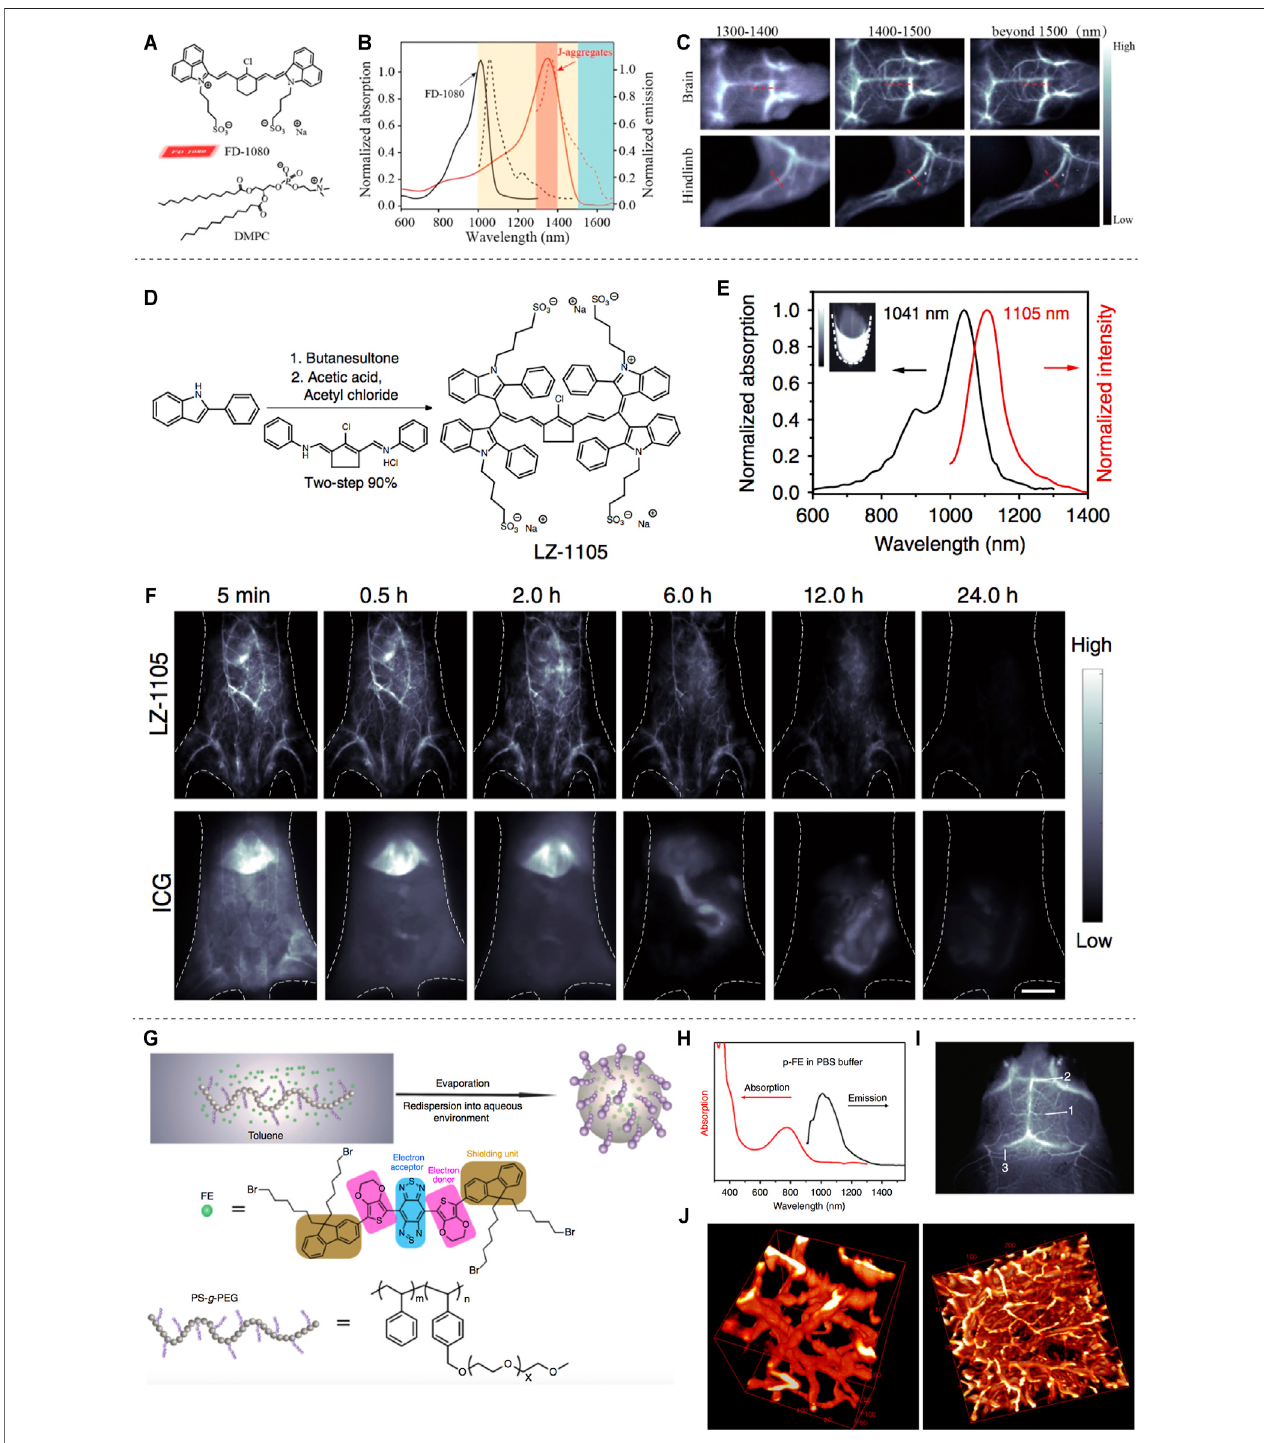
FIGURE3| NIR-IIbasedvascularimaging. (A) StructureofFD-1080andDMPC. (B) NormalizedabsorptionandemissionofFD-1080monomerandJ-aggregates. (C) FluorescenceimagingofbrainandhindlimbvesselsachievedbyJ-aggregates(reproducedfrom(Sunetal.,2019)withpermissionfromAmericanChemicalSociety). (D) Synthetic route of LZ-1105. (E) Normalized absorption and intensity of LZ-1105. (F) Fluorescence imaging of mice body injected with LZ-1105 (reproduced from (Li et al., 2020) with permission from Springer Nature). (G) Synthesis of p-FE. (H) Absorption and emission spectra of p-FE in PBS. (I) Imaging of mouse brain vessels injected with p-FE. (J) 3D reconstruction of vasculatures in brain (reproduced from (Wan et al., 2018) with permission from Springer Nature).